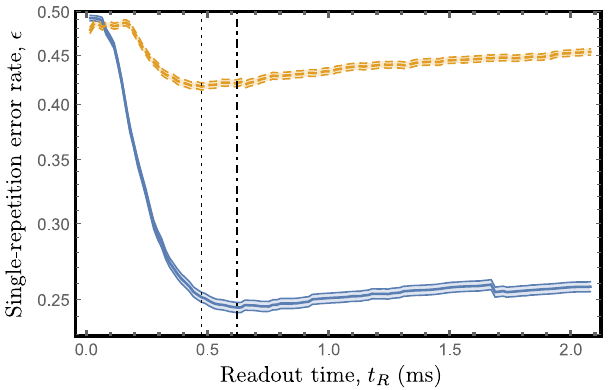
FIG. 4. Average single-repetition readout error rate ϵ as a function of readout time t R in the absence of added noise (solid blue line) and in the presence of added noise (dashed yellow